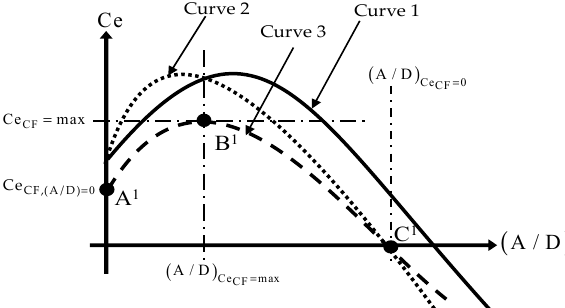
Figure 3. Illustration of the parameter scaling procedure by three curves: Curve 1: default CF excitation coefficient curve at a particular non-dimensional frequency in VIVANA, Curve 2: after amplitude modification, Curve 3: after the excitation coefficient modification.